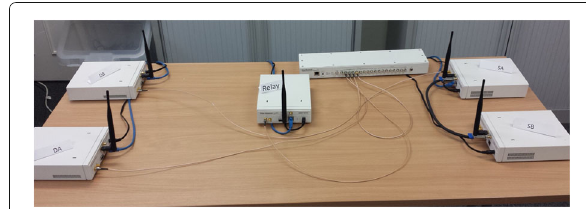
Fig. 5 Setup for HW evaluation (Ettus Research USRPs). Source transmissions are prerotated [23–25] to imitate the AWGN channel conditions (as used in the numerical evaluation). To allow a strict control of HSI channels SNR in the HW setup, the HSI channels are emulated by adding a Gaussian noise to the respective source signal and the resulting emulated HSI is passed to destinations via UDP. This also avoids the problem of node visibility where direct links S A → D A and